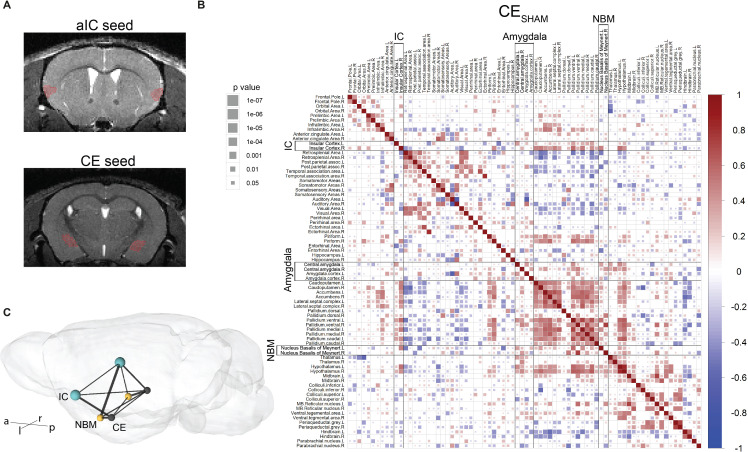
ROI-based functional connectivity of the control group.(A) Seed region masks used for functional connectivity of the anterior insular cortex (aIC) and central nucleus of amygdala (CE). (B) Functional connectivity in the CESHAM group with significant (one sample t-test, p<0.05) Fisher z-transformed Pearson correlation coefficients between each pair of brain regions (blue-to-red scale) is shown (significance of correlations reflected by the size of the square). (C) Region-based functional connectivity of IC, CE, and Nucleus Basalis of Meynert (NBM; from the correlation matrix in B). Edge thickness depicts connectivity strength.Figure 1—figure supplement 1—source data 1.fMRI cross-correlation matrix of CESHAM in Figure 1—figure supplement 1B.